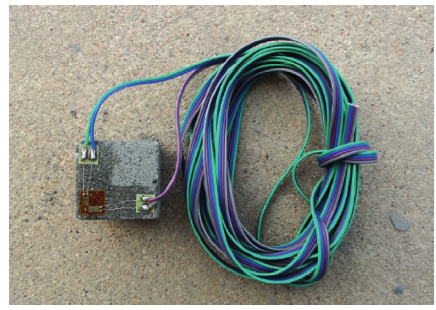
Figure 7: Resistance strain bricks and conductors.